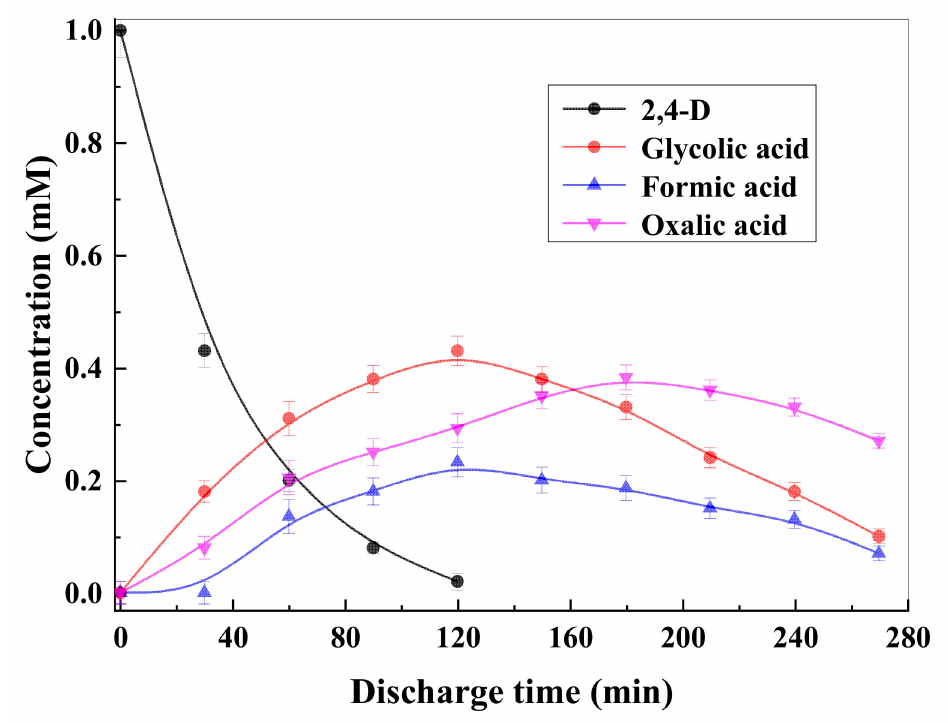
Figure 12. Carboxylic acids determined by IC during RFD (input power, 200 W; [2,4-D] 0 , 1.0 mM; pH 0 ,